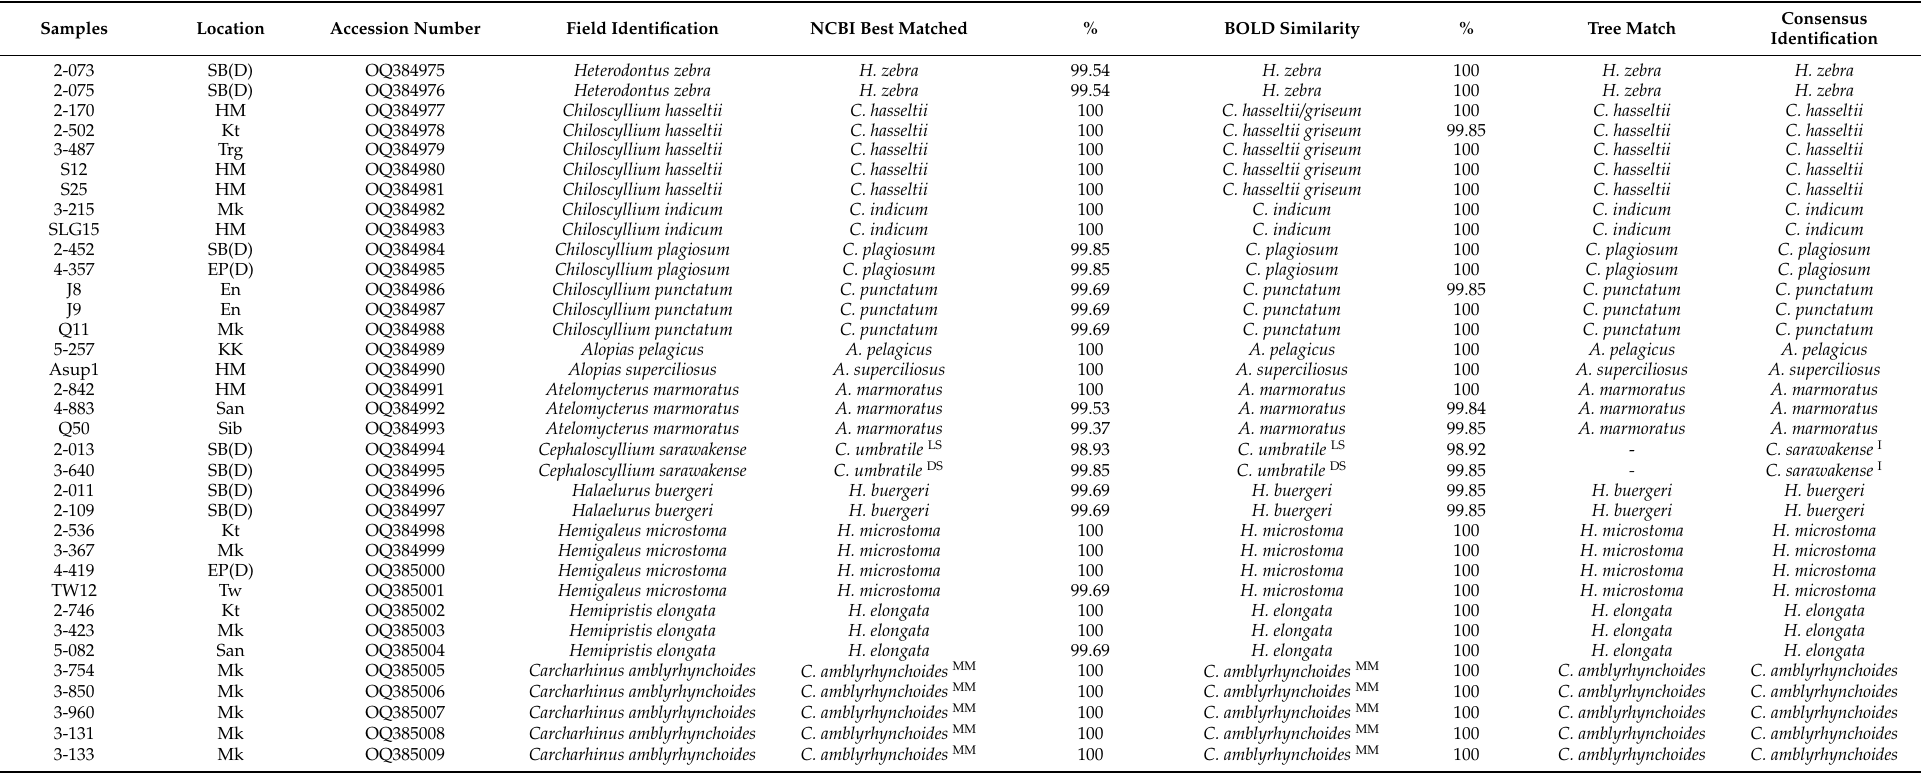
Table 1. Verification of the identity of barcoded shark and batoids species. Given are the sample code, sample location, NCBI accession number, field identification, best matched species from NCBI GenBank, similarity species and % from BOLD, tree-based identification, and the consensus identification. West coast of Peninsular Malaysia (WP): HM = Hutan Melintang, Pen = Penang, PP = Pasir Penambang, Sb = Sungai Besar, and Tk = Tanjung Karang; East coast of Peninsular Malaysia (EP): En = Endau, EP(D) = East coast of Peninsular Malaysia (DOF survey), Kt = Kuantan, Mer = Mersing, and Trg = Terengganu; Sarawak (SR): Btw = Bintawa, Kc = Kuching, Mk = Mukah, Sib = Sibu, SR(D) = Sarawak (DOF survey), and Srk = Sarikei; Sabah (SB): Kd = Kudat, KK = Kota Kinabalu, San = Sandakan, SB(D) = Sabah (DOF survey), and Tw =